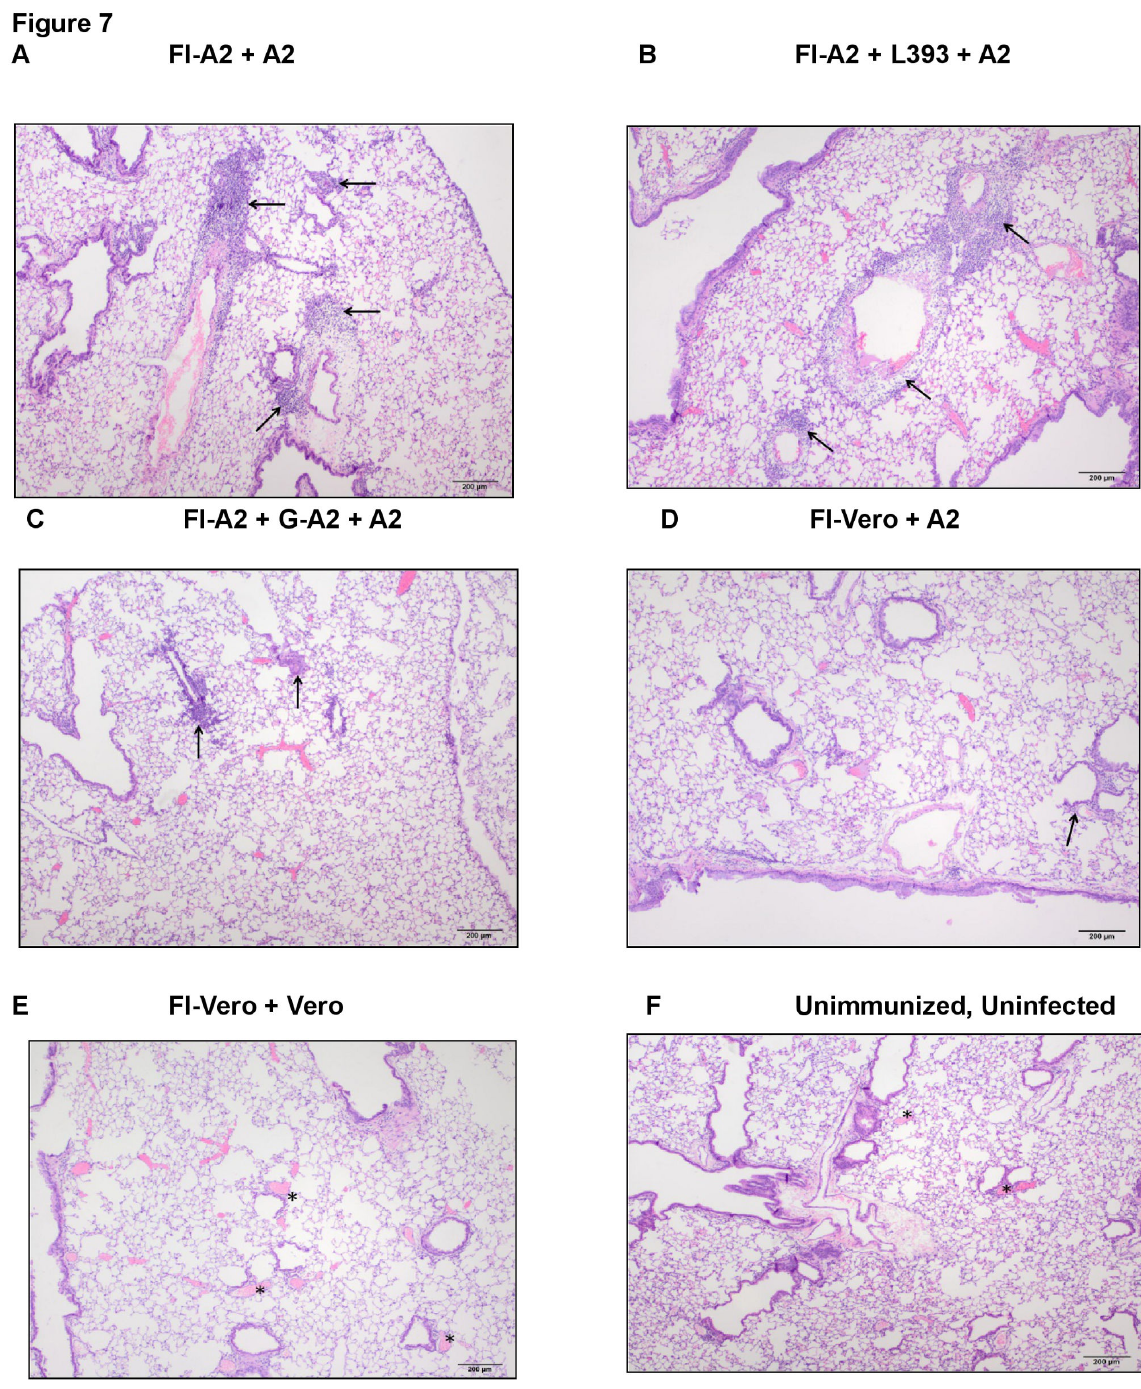
Figure 7. Lung histopathology in vaccinated mice. Lung histopathology was examined by hematoxylin and eosin staining in (A) mice i.m. vaccinated with FI-A2 and then challenged with RSV A2 (FI-A2), (B) mice vaccinated with FI-A2 and control L393 peptide and challenged with RSV A2 (FI-A2+L393), or (C) mice vaccinated with FI-A2 and G-A2 peptide and challenged with RSV A2 (FI- A2+G-A2) at day 3 post-challenge. The arrows mark areas in inflammatory infiltrates. Control groups were immunized with FI-Vero cell lysate and challenged with either (D) RSV A2 (FI-Vero) or (E) uninfected, Vero lysate (FI-Vero+Vero). (F) Lung histopathology of an uninfected, unimmunized BALB/c mouse. The perivascular areas (asterisks) are devoid of inflammatory infiltrates. 40X original magnification, Scale bar= 200mm. doi: 10.1371/journal.pone.0083075.g007 PLOS ONE |